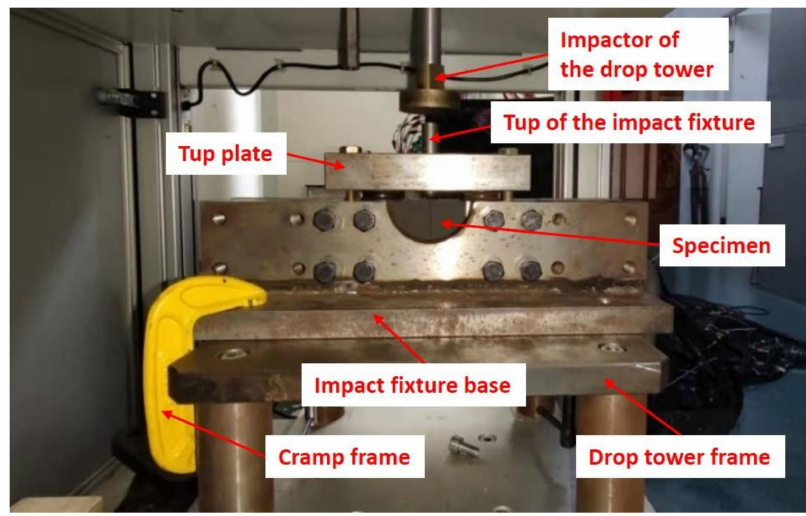
Figure 3. The site-photo of impact